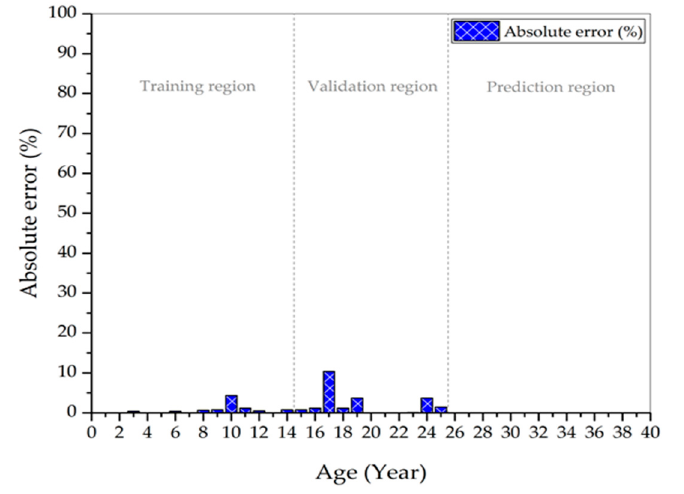
Figure 9. The absolute error percentage between the computed and predicted health index. The average percentage error between the predicted and computed HI was performed based on Equation